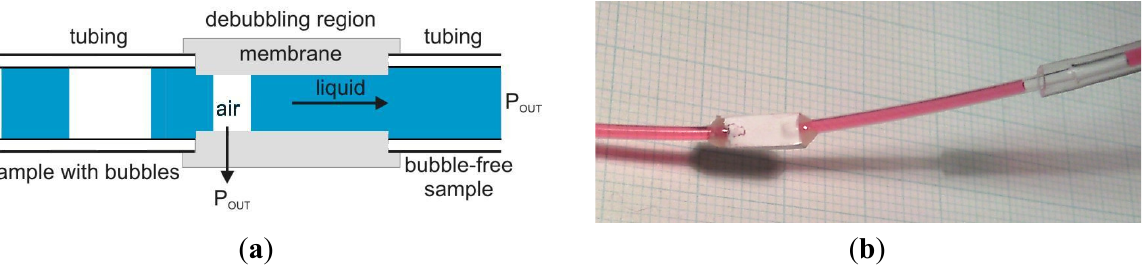
Figure 2. Inline debubbler coupled with tubing. ( a ) Schematic and operating principle; ( b ) Picture of demonstration debubbler with air arriving from the